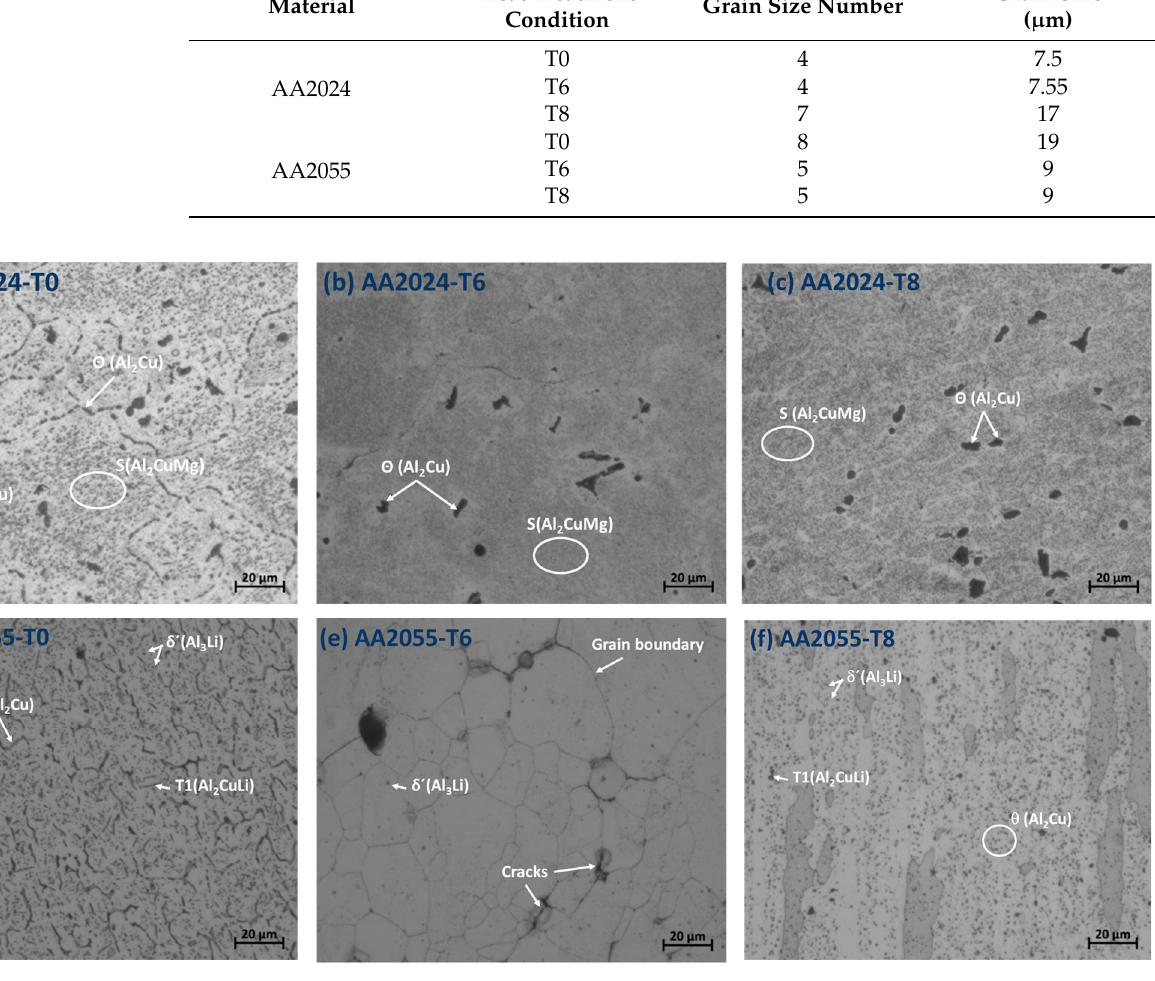
Figure 3. OM microstructure of the AA2024 ( a – c ) and AA2055 ( d – f ) aluminum alloys under the three heat treatment